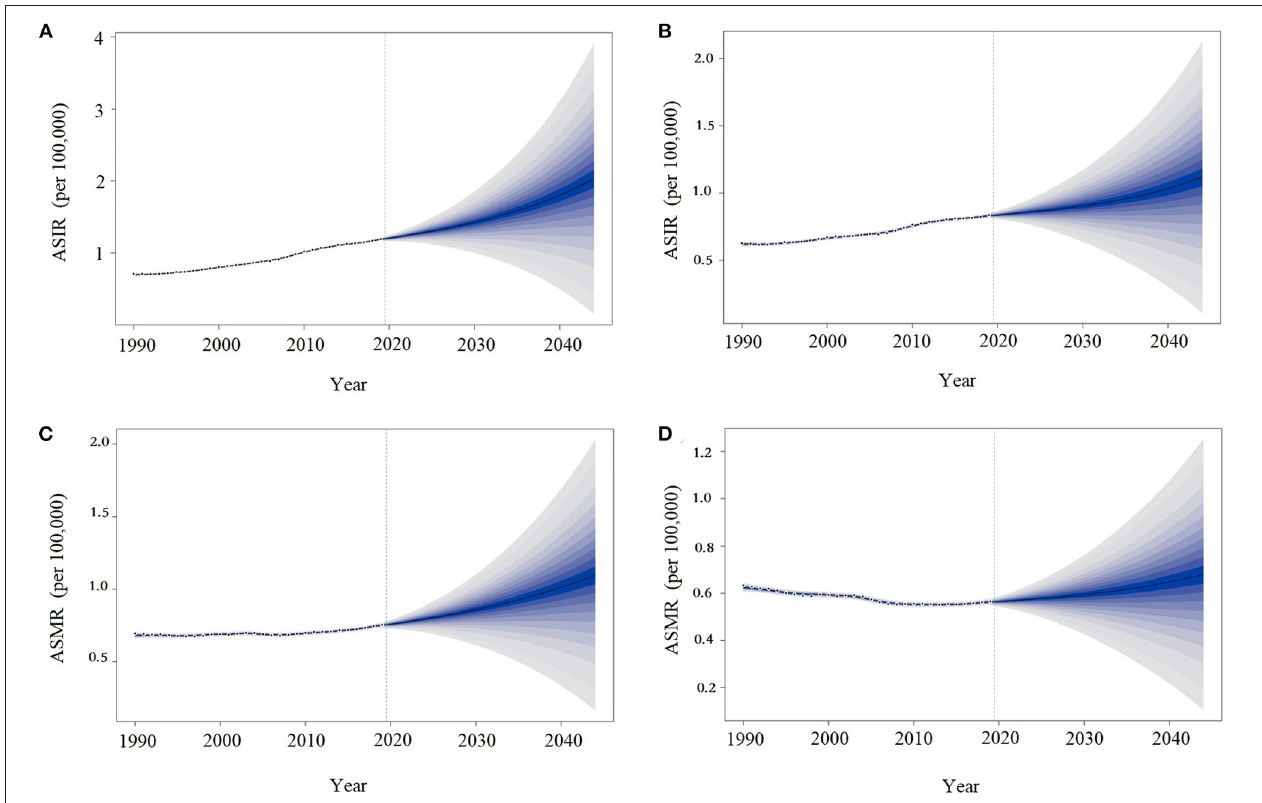
FIGURE 3 | Trends in multiple myeloma incidence and death rates by sex in China: observed (dashed lines) and predicted (solid lines). The ASIR in males (A) , ASMR in males (B) , ASIR in females (C) , and ASMR in females (D) . ASIR, age-standardized incidence rates; ASMR, age-standardized death rates.